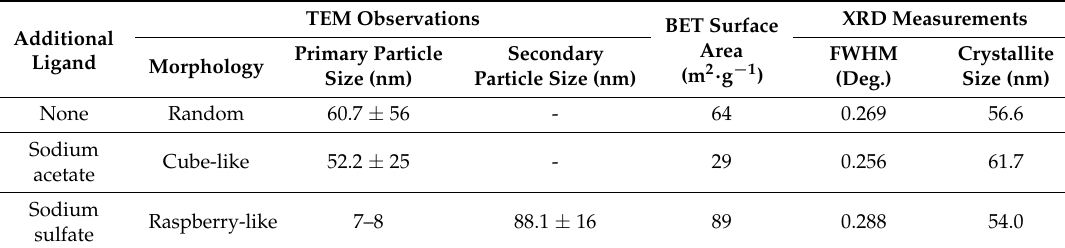
Table 1. Structural characteristics of the Co 3 O 4